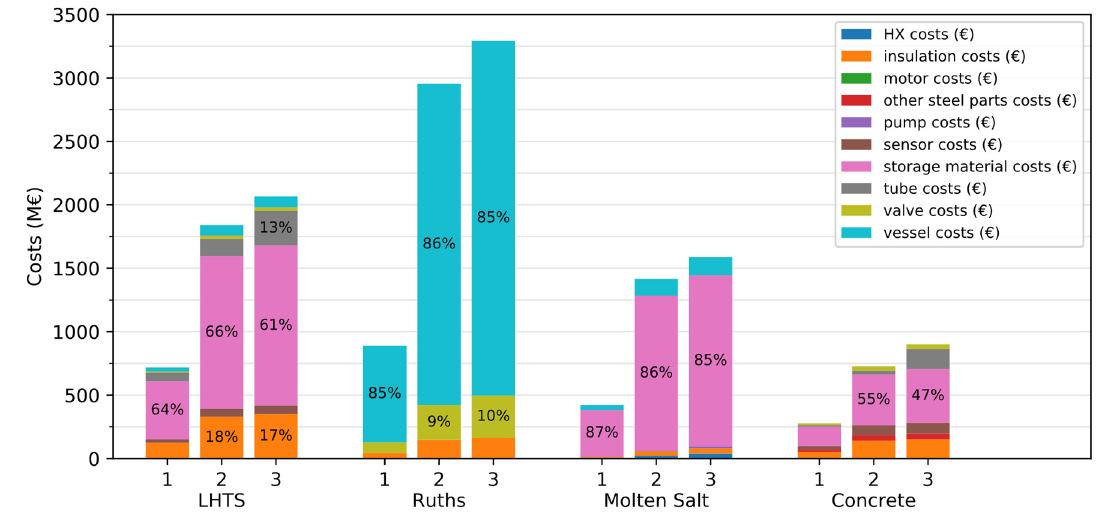
Figure 9. Cost structure for all selected TES technologies for Case 1 for three capacity (Cap.)/heat load (HL) scenarios—1: Figure 9. Low Cap./Low HL, 2: High Cap./Low HL, 3: High Cap./High HL.